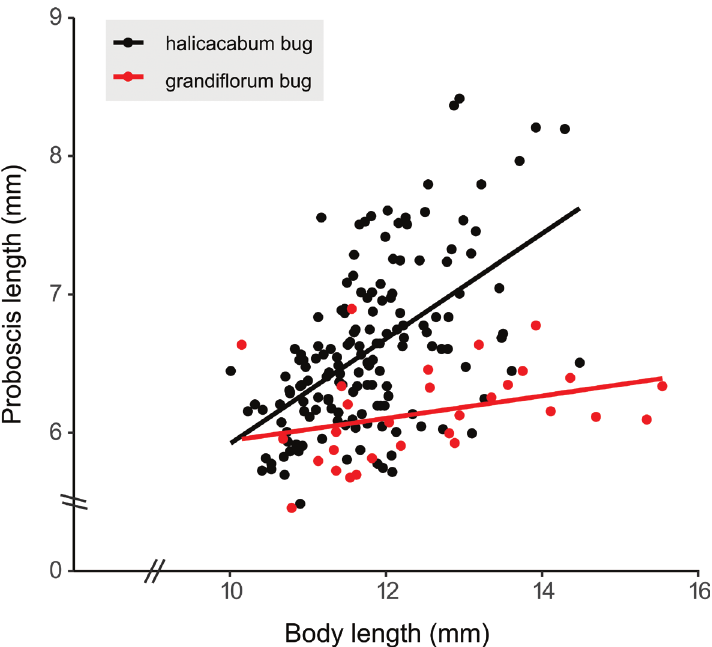
Figure 4. Linear regressions showing the relationship between proboscis length and body length for adult Leptocoris mutilatus found in association with Cardiospermum halicacabum and C. grandiflorum . Each point represents an individual.